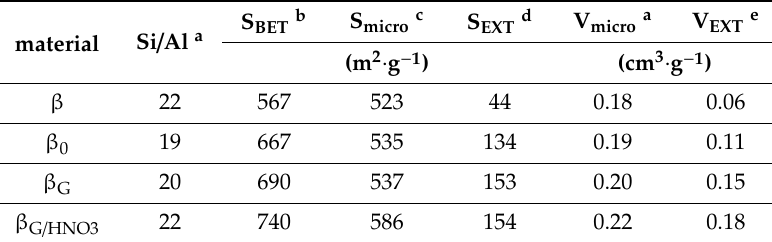
Table 1. Chemical composition and textural properties derived from N 2 physisorption of the zeolites studied.